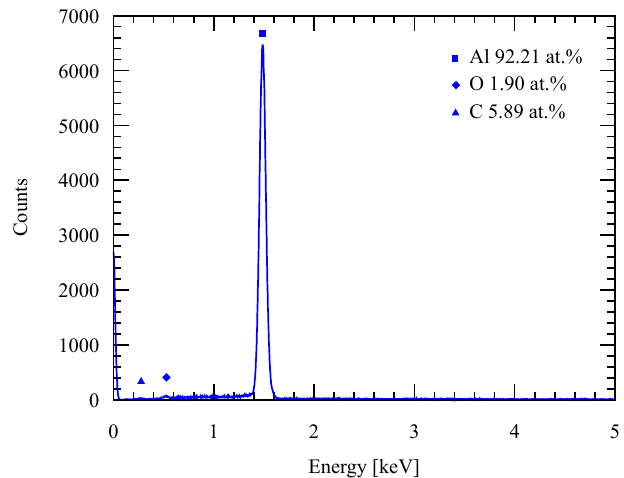
Figure 9. EDS spectrum of the deposited film with 20 mA/cm 2 current density at 50 ◦ C.